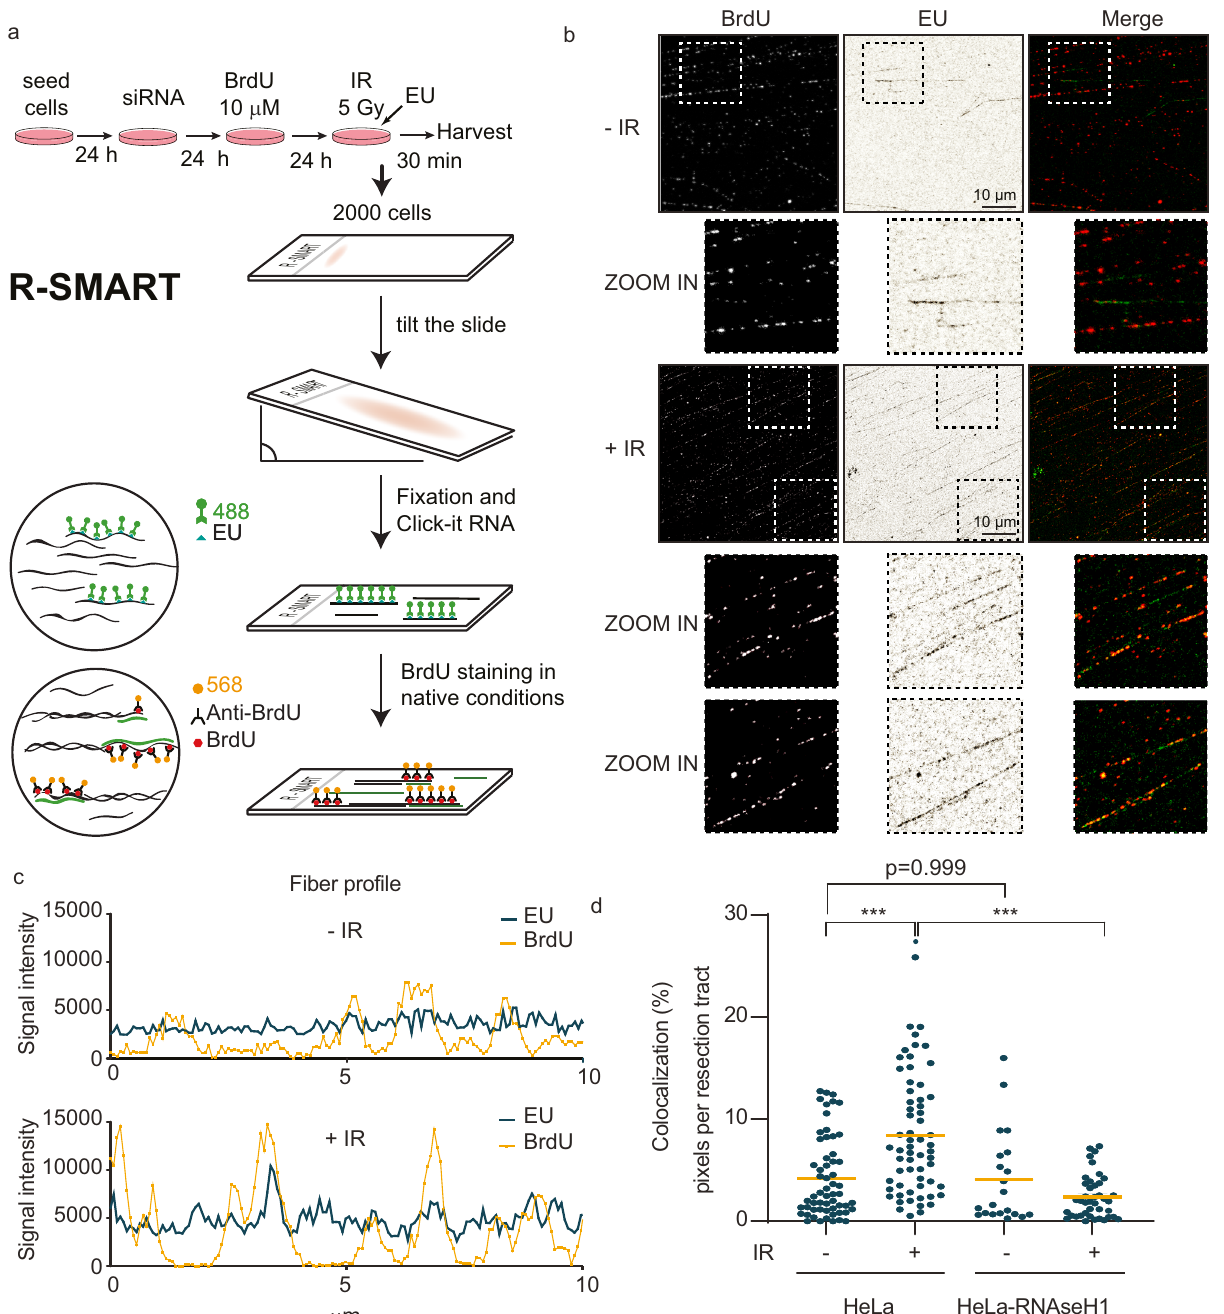
Fig. 2 | Nascent RNAs colocalize with DNA resection tracts in irradiated HeLa cells. a Schematic representation of the developed R-SMART technique. b Representative images of DNA resection tracts (black background) and nascent RNAs (white background) upon 5Gy irradiation, using non-denaturing conditions for BrdU staining and EU labeling, respectively. n =3 biologically independent experiments. Scale: 10 μ m. c Representative quanti fi cation of fi ber pro fi les for EU HeLa-RNAseH1 with stable expression of ectopic RNAaseH1, a model useful for assessing cellular roles of RNA:DNA hybrids 28,29 . RNaseH1 expression reduced the extent of post-IR interaction between ssDNA and nascent RNA (BrdU colocalization with EU), consistent with a scenario that ssDNA tracts may indeed be covered or protected in some regions from degradation by nascent com- plementary RNA molecules (Fig. 2d). Altogether, these results support the notion that de novo RNA synthesis after DSB